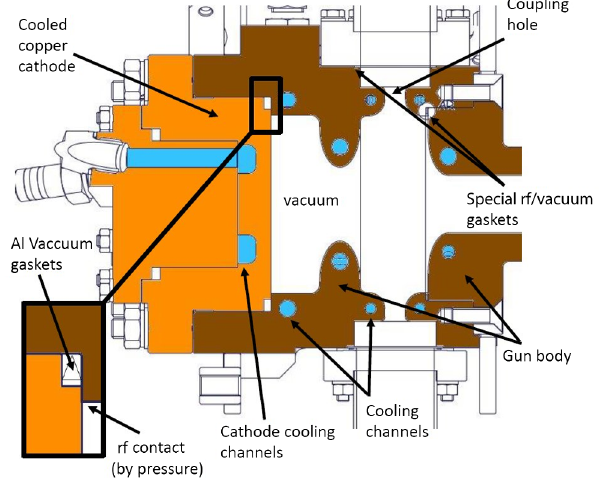
FIG. 15. Mechanical detail of the cathode insertion and vacuum